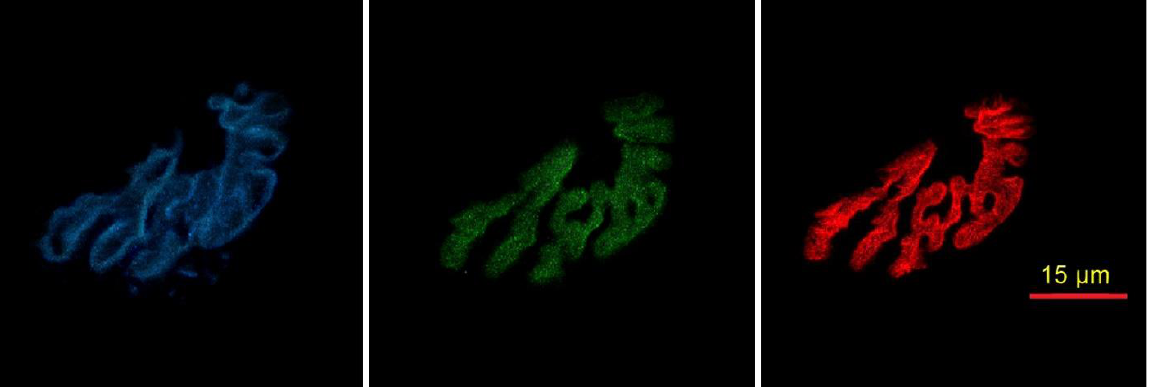
Figure 3. Representative immunofluorescent staining of subcellular features of the NMJ. Pre-synaptic active zone P/Q calcium channels are identified with AlexaFluor 647 (blue), pre-synaptic Bassoon is identified with AlexaFluor 488 (green), while associated post-synaptic acetylcholine receptors are visualized with rhodamine (red).